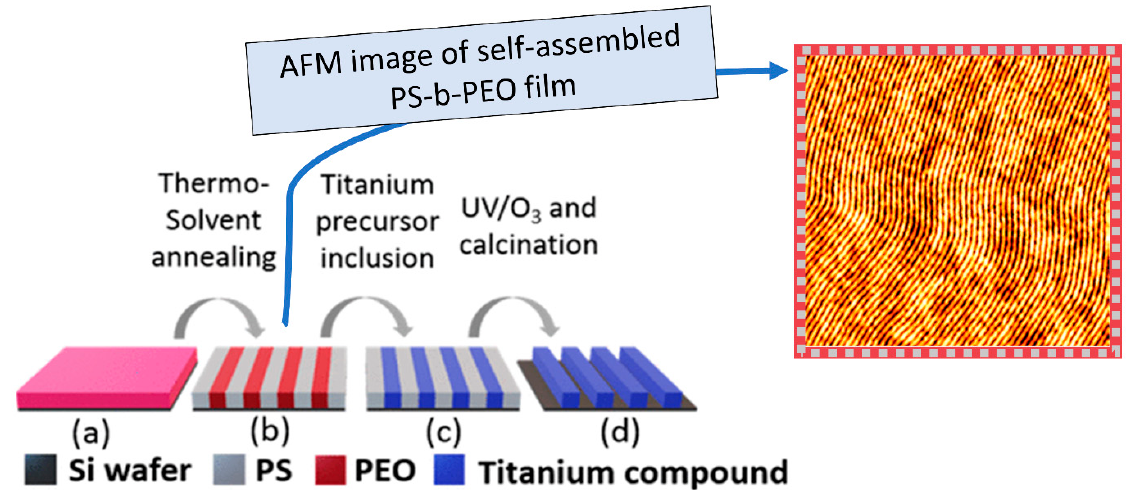
Figure 3. Illustration of the formation of titanium dioxide nanowires. ( a ) Si substrate with an as-cast film of PS-b-PEO solution, ( b ) post thermo-solvent vapour annealing self-assembled PS-b-PEO is achieved. ( c ) film after titanium precursor inclusion. ( d ) post UV ozone and calcination process titanium dioxide nanowires. AFM image (2 × 2 µm 2 ) of the self- assembled PS-b-PEO thin film is shown on the furthest right. Reprinted (adapted) with permission from ([37]). Copyright (2018) American Chemical Society.